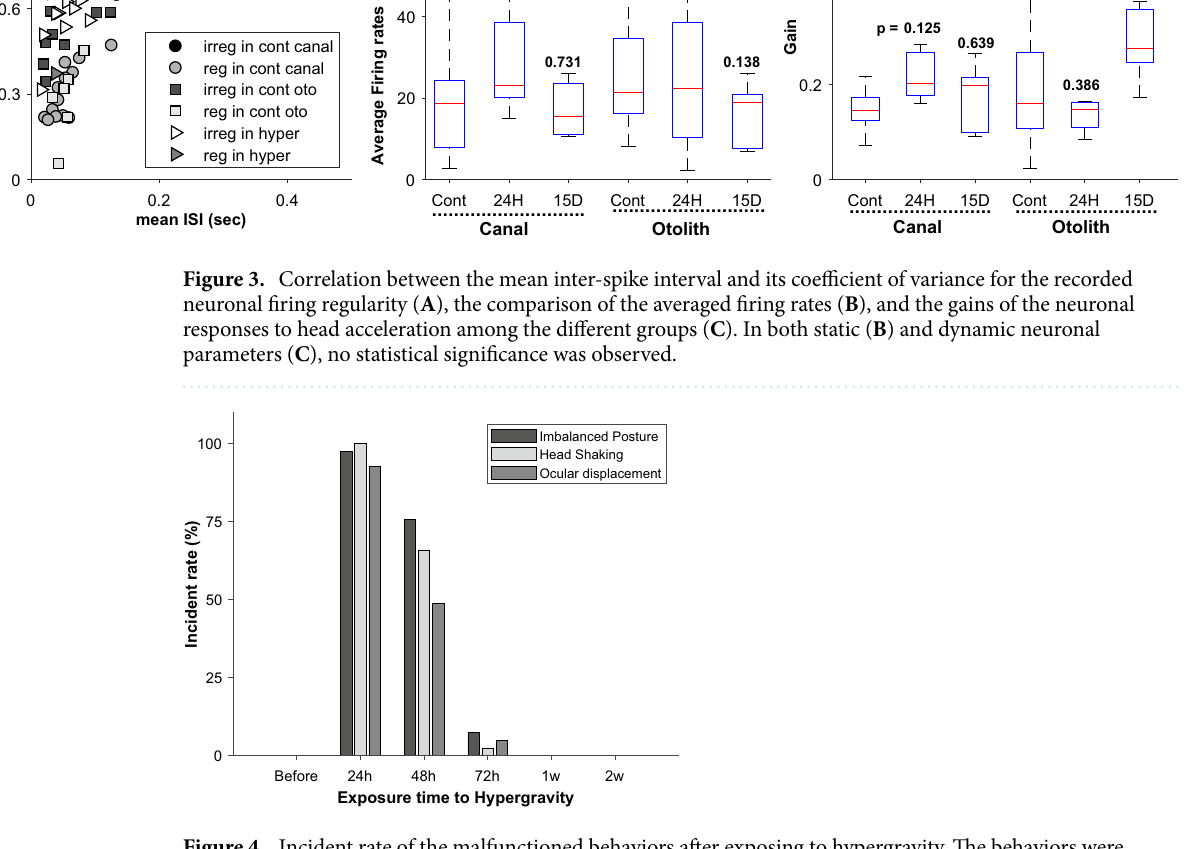
Figure 4. Incident rate of the malfunctioned behaviors after exposing to hypergravity. The behaviors were identified related with the general vestibular function, such as postural balance, head position maintenance, and ocular